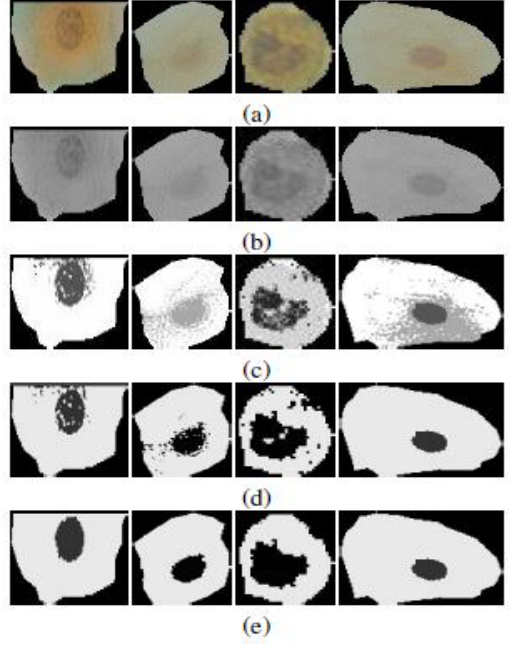
Figure 9. Samples of sputum cells through the different segmentation stages. ( a ) Sputum cells; ( b ) Conversion to gray level; ( c ) Mean shift segmentation; ( d ) Mode merging; ( e ) Region